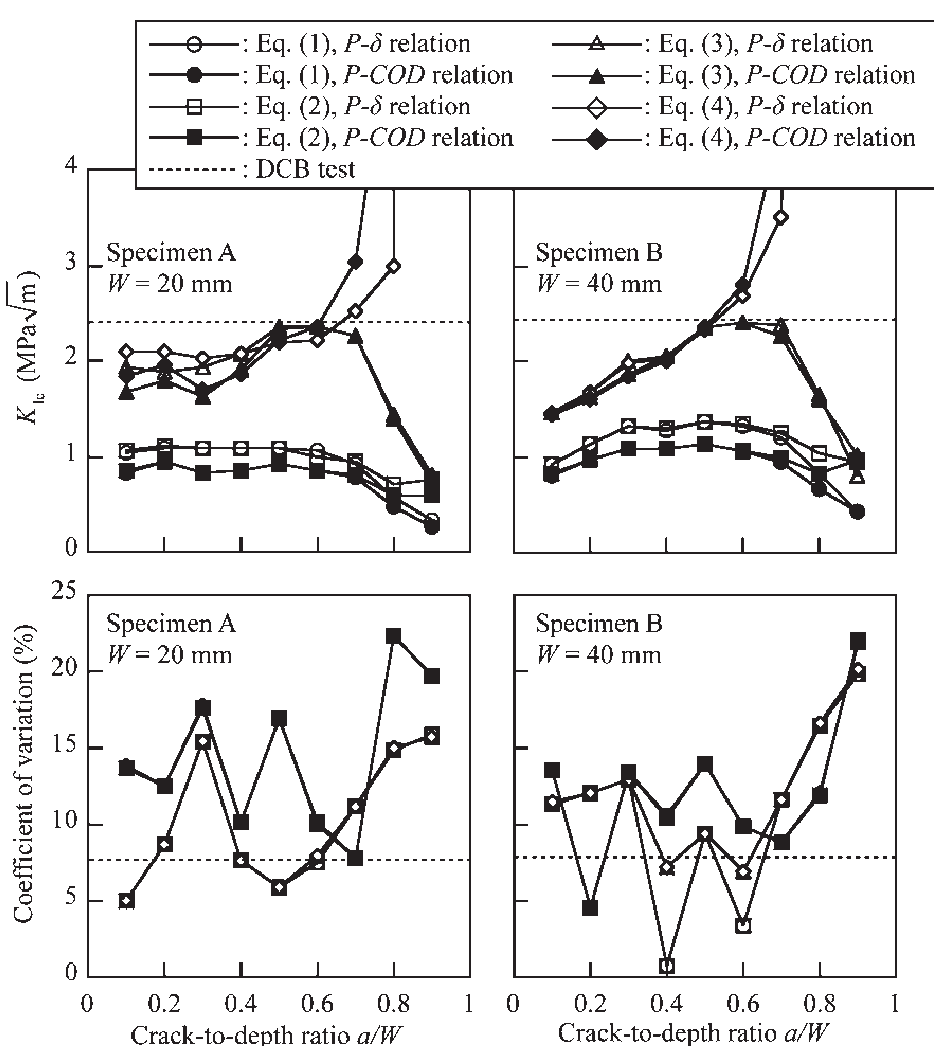
Figure 3 Comparison of the relationships between K by DCB